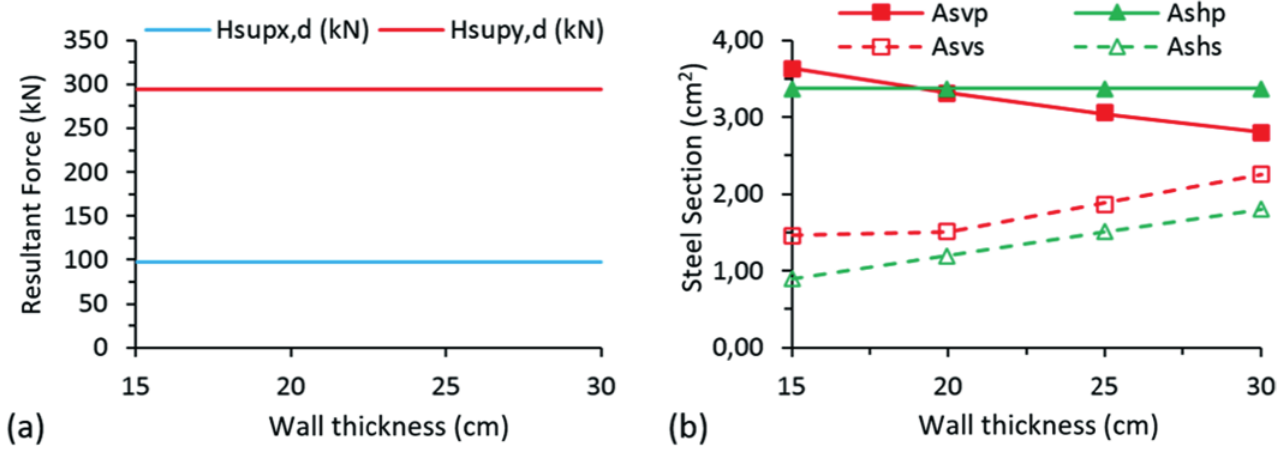
Upper resultant forces under the influence of the variation in wall thickness of the socket